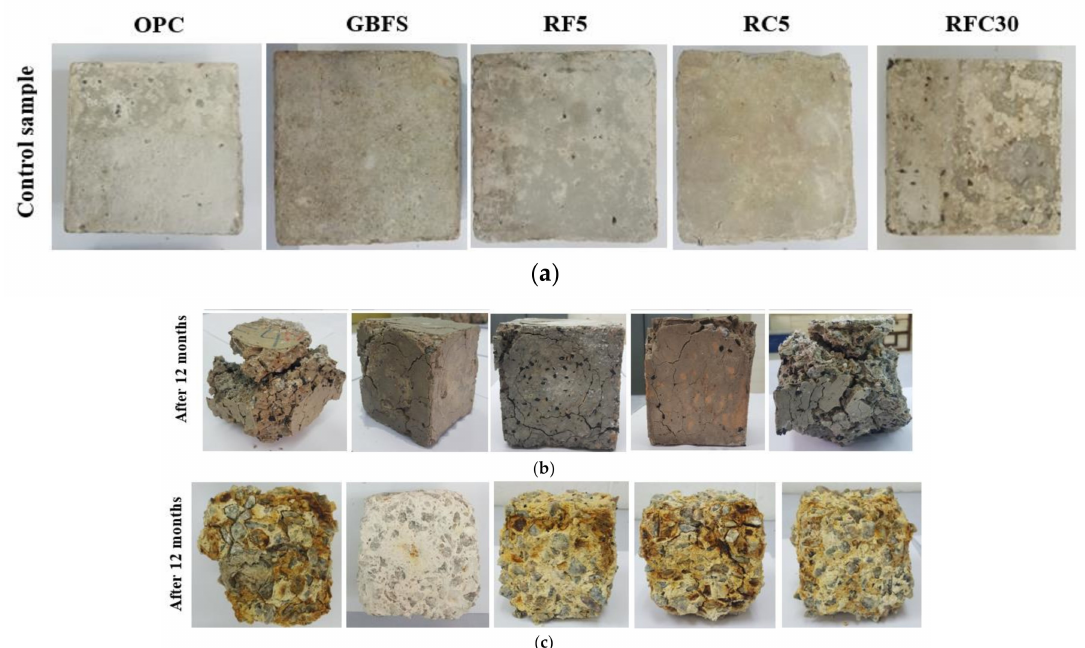
Figure 5. Surface texture of the ( a ) modified rubberized concretes, and after 365-days immersed in the ( b ) MgSO 4 solution (sulphate), and ( c ) H 2 SO 4 solution